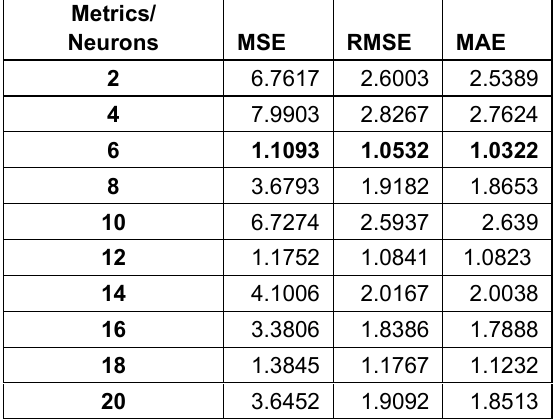
Table.4 Performance Error Metrics resulted by CU